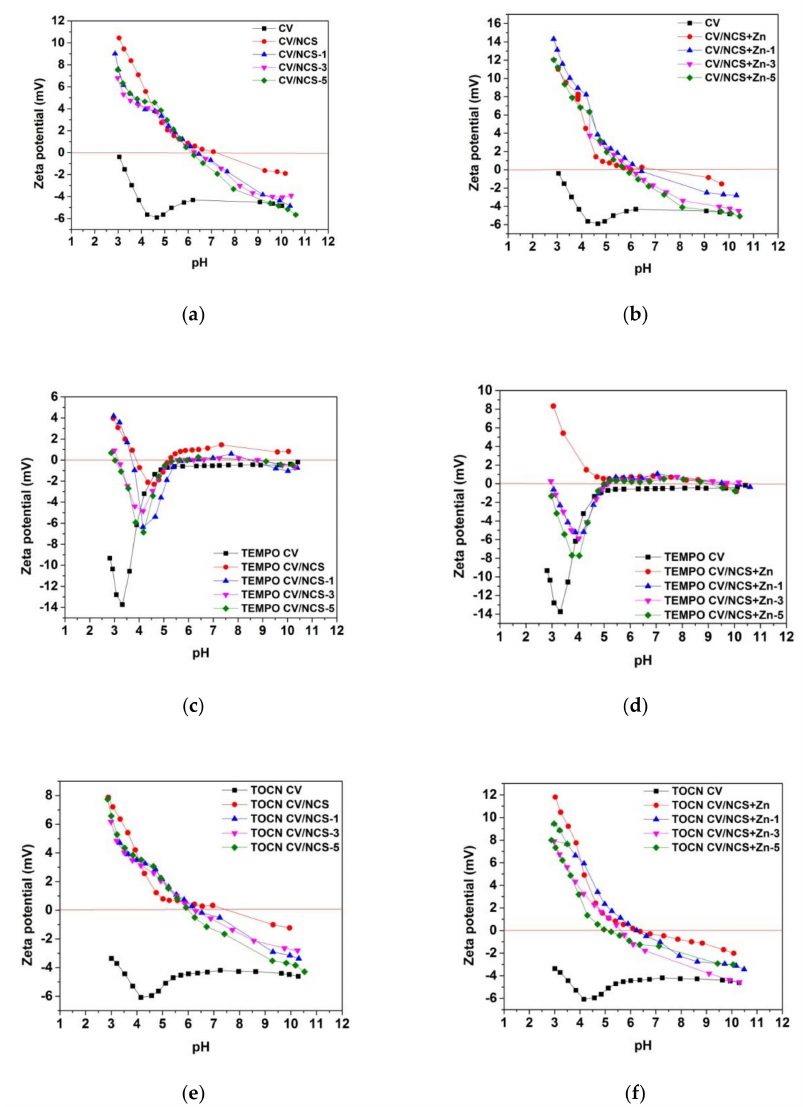
Figure 5. Zeta potential of NCS ( a , c , e ) and NCS + Zn ( b , d , f ) functionalized viscose fabrics, before and after 1, 3 and 5 washing cycles; modified from